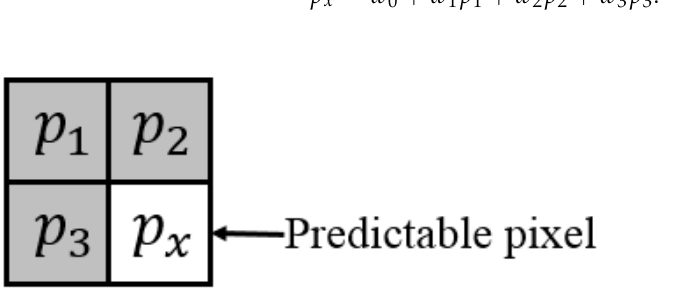
Figure 2. Predictable pixel and its three neighboring pixels.